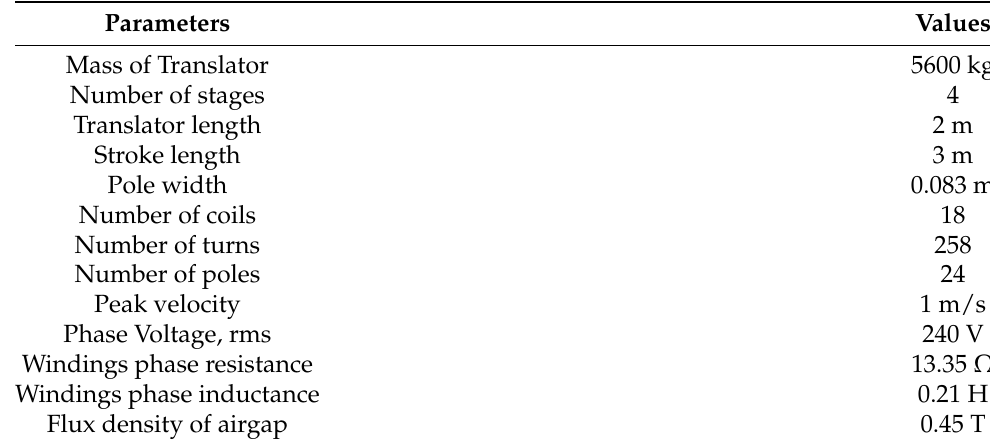
Table 1. Parameters of the C-GEN generator.